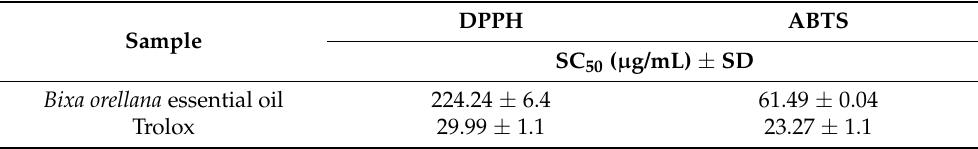
Table 5. Antioxidant activity of essential oil from Bixa orellana .